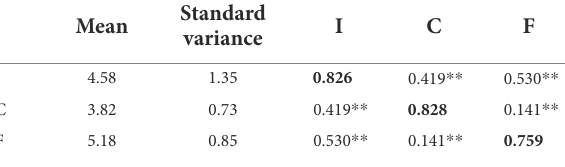
TABLE 3 Mean and standard variance of the questionnaire factors.